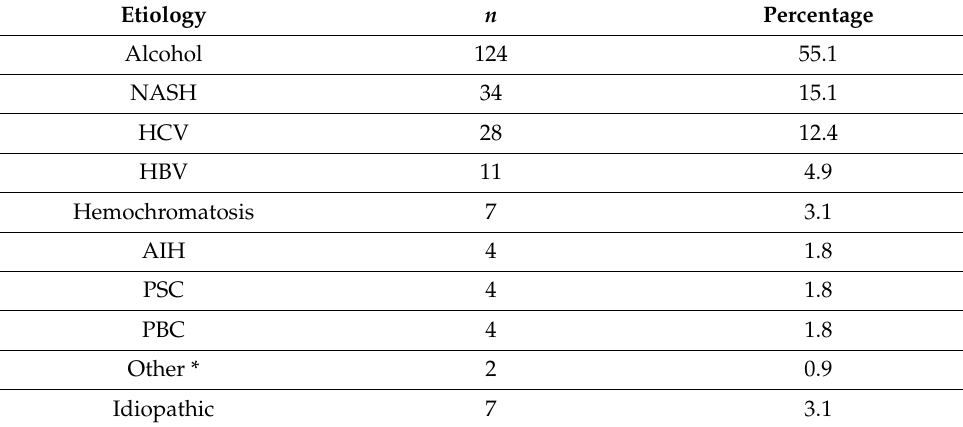
Table 2. The distribution of the various etiologies of cirrhosis among the 225 study participants. NASH, non-alcoholic steatohepatitis; HCV, hepatitis C virus; HBV, hepatitis B virus; AIH, autoim- mune hepatitis; PSC, primary sclerosing cholangitis; PBC, primary biliary cirrhosis. Etiology n Percentage Alcohol 124 55.1 NASH 34 15.1 HCV 28 12.4 HBV 11 4.9 Hemochromatosis 7 3.1 AIH 4 1.8 PSC 4 1.8 PBC 4 1.8 Other * 2 0.9 Idiopathic 7